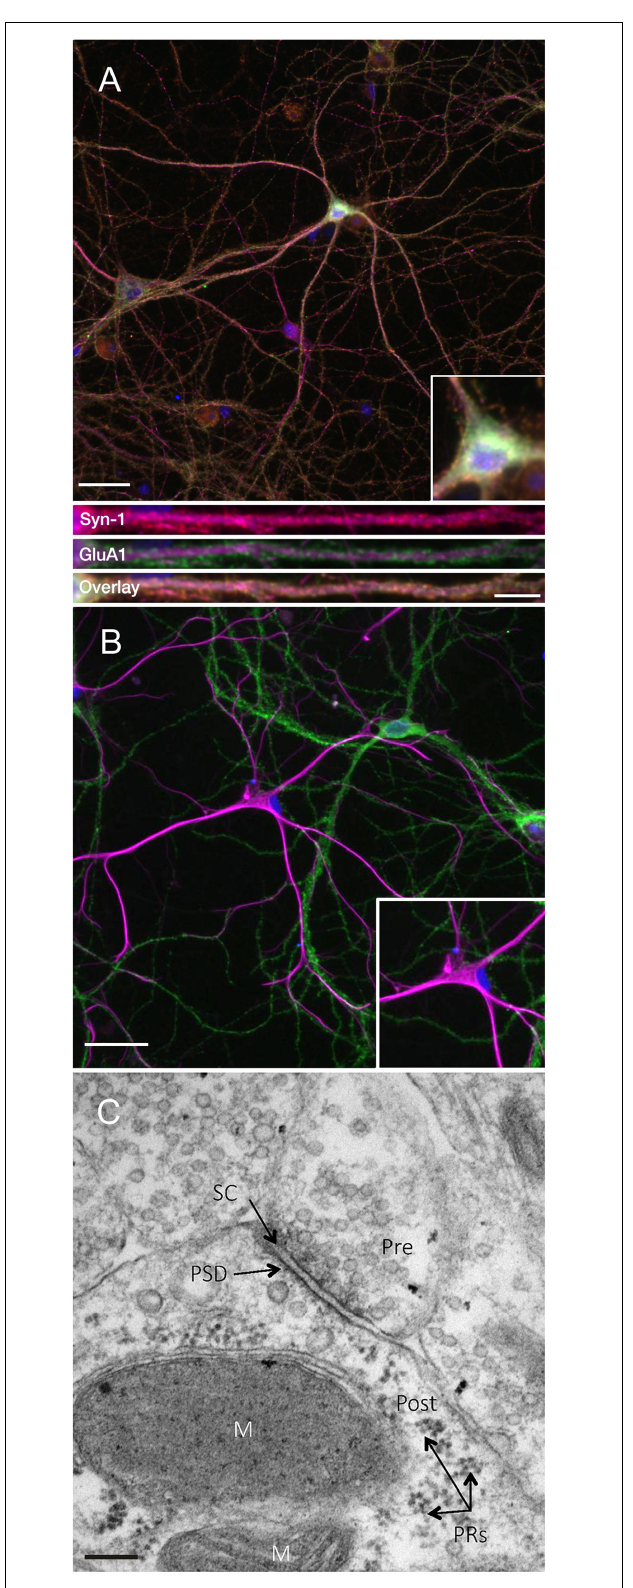
to decline at this timepoint and was not significantly different from controls 24 h later (Arc: 1.01 ± 0.14, p = 0.42; Zif268: 1.03 ± 0.14, p = 0.15). At no point was SP2 significantly different from controls (15 min: 1.04 ± 0.15, p = 0.20; 30